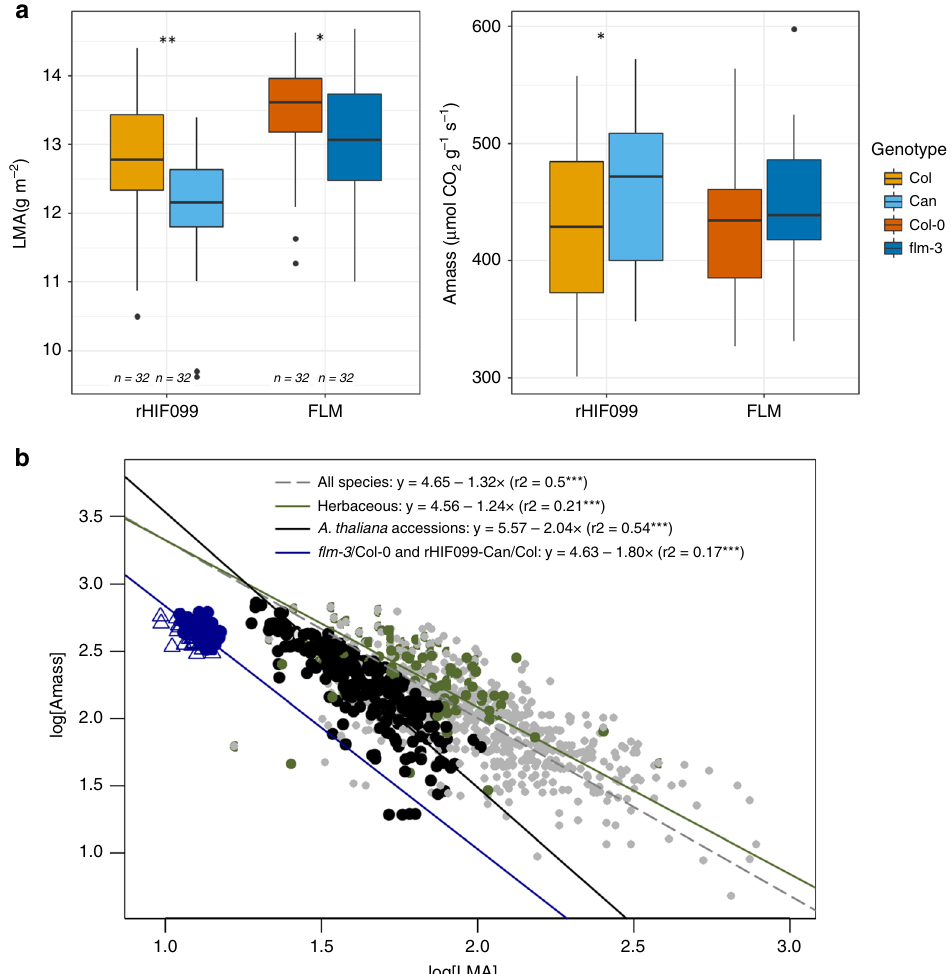
Fig. 4 Allelic variation at FLM modulates important traits of the leaf economics spectrum. a Boxplots representing the difference in leaf dry mass per area (LMA, g m − 2 ) and photosynthetic rate by unit of dry mass ( A mass , nmol CO 2 g − 1 s − 1 ) between the two allelic lines of rHIF099 as well as between fl m-3 and Col-0. Source data are provided in Supplementary Table 2. b Variations in leaf physiology associated with FLM variants compared to the worldwide leaf economics spectrum, i.e., the relationship between log 10 -transformed A mass and LMA. Gray points represent all plant species from the GLOPNET dataset 12 ( n = 701). Green points represent only herbaceous species from the GLOPNET dataset ( n = 124). Black circles represent natural accessions of A. thaliana 14 ( n = 340). Blue circles and triangles represent fl m-3 /Col-0 and the rHIF099-Can/Col plant groups measured in this study, respectively ( n = 32 per genotype). Regressions have been estimated with standard major axis (SMA). r 2 : coef fi cients of correlation from SMA regressions. *** p <